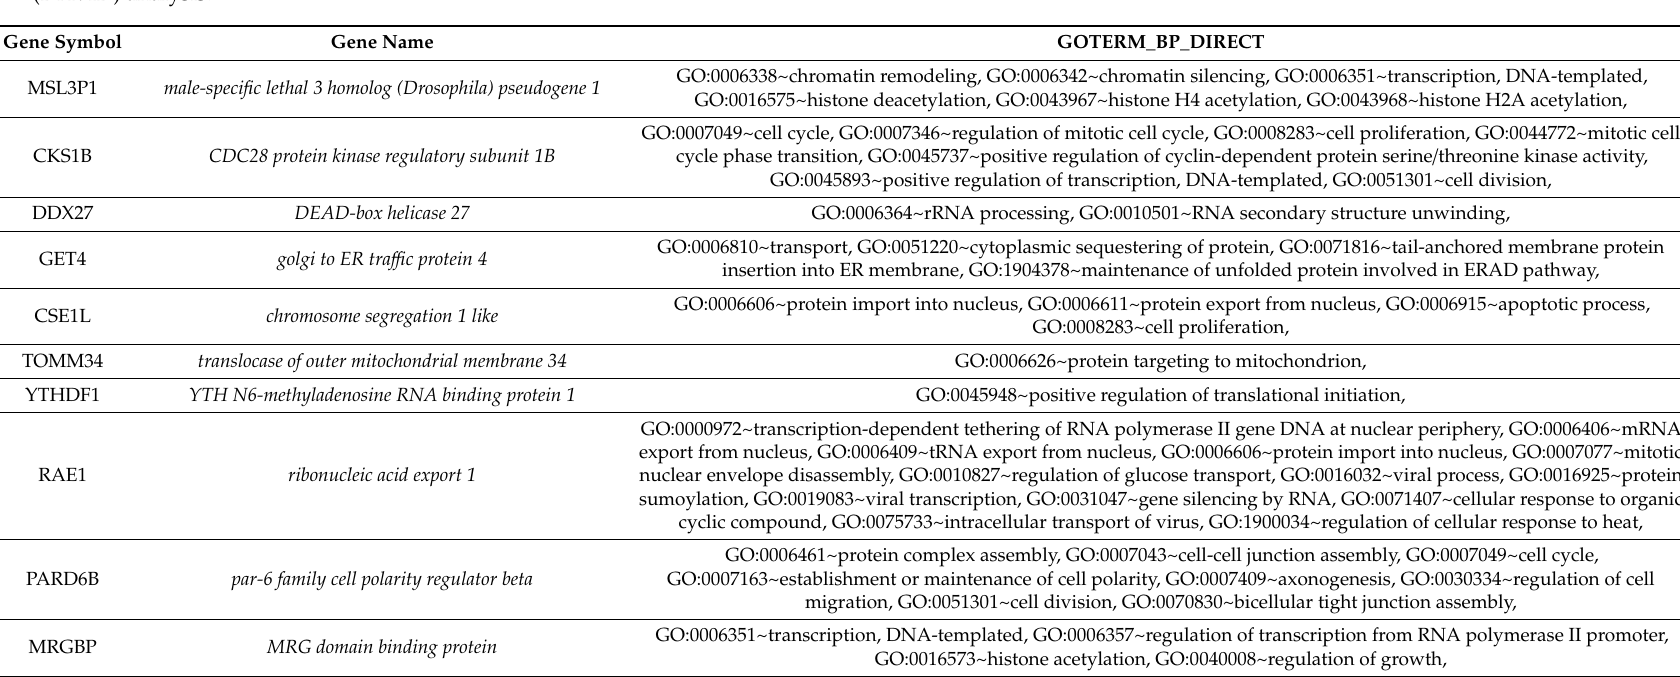
Table 1. Top 10 genes altered in intestinal- and di ff use-type gastric cancer (GC). The top 10 genes that have significant di ff erence between intestinal-type (CIN; chromosomal instability) and di ff use-type (GS; genomically stable) in TCGA RNAseq data are shown. A total of 2815 probe set IDs were significantly di ff erent between CIN and GS (Student’s t -test, p < 0.00001). Gene Ontology (GO) of the 10 genes are shown from the Database for Annotations, Visualization and Integrated Discovery (DAVID)